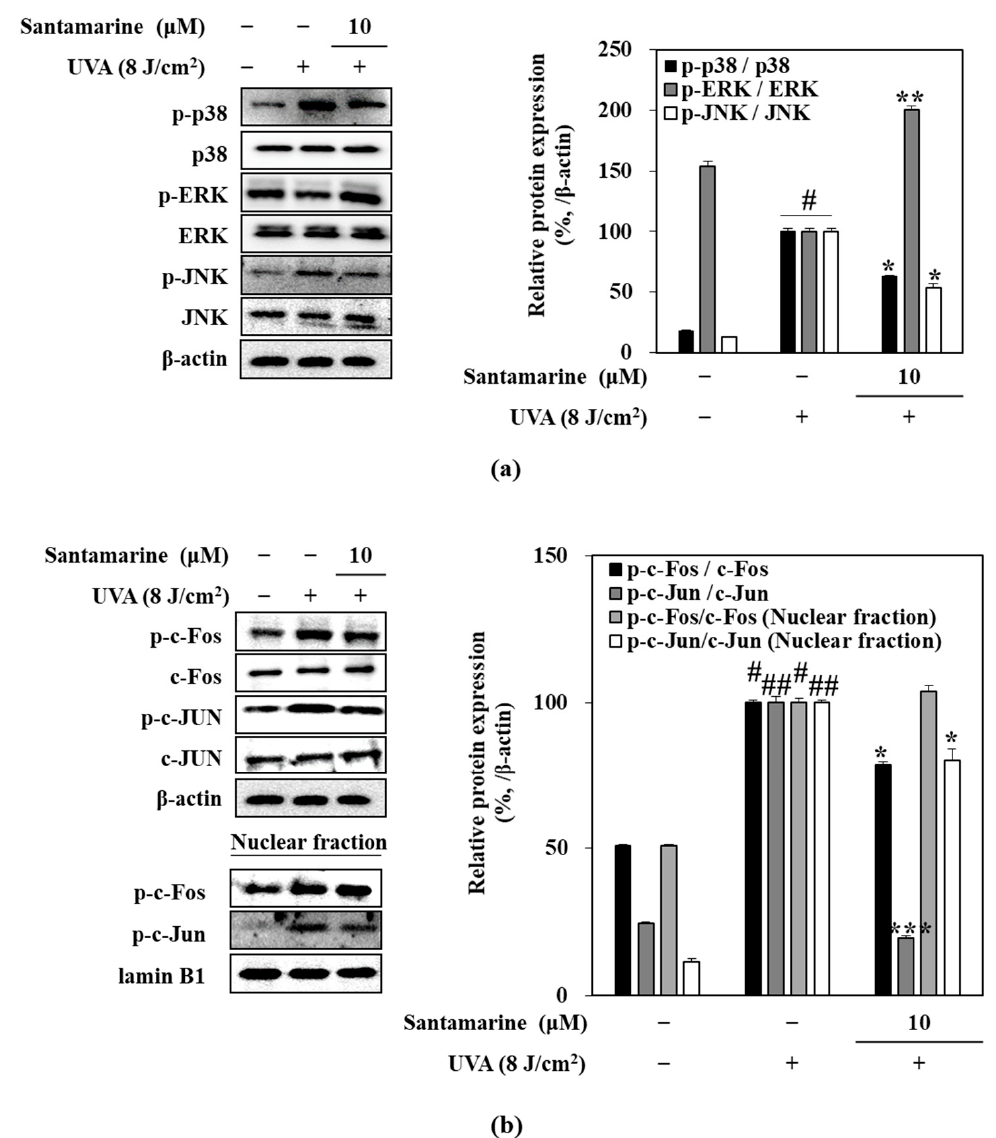
Figure 5. Effect of santamarine on the MAPK/AP-1 pathway activation. UVA-irradiated (8 J/cm 2 ) HDFs were treated with santamarine for 24 h and the harvested cells were used to measure the total and phosphorylated levels of ( a ) p38, ERK and JNK MAPKs, and ( b ) c-Fos and c-Jun of AP-1 complex via Western blot. β -actin and lamin B1 were used as loading controls. * p < 0.05, ** p < 0.01 and *** p < 0.001 vs. UVA-irradiated untreated control. # p < 0.05 and ## p < 0.01 vs. non-irradiated control.